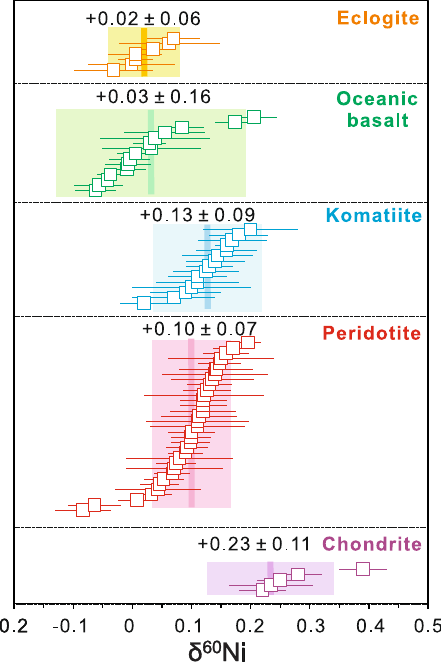
Fig. 2 Mass-dependent Ni isotopic variations of terrestrial silicate rocks and chondrites from this study. The bands represent the average value for each sample category with 2 SD. The δ 60/58 Ni of fi ve chondrite samples fall within the chondritic average de fi ned by all published data (0.23 ± 0.11 ‰ ). The fertile and non-metasomatized peridotites with chemical compositions most close to the BSE 44 have homogeneous Ni isotopic compositions, while those experienced secondary modi fi cation have relatively large variations. Therefore, only fertile, non-metasomatized peridotites are used for the average calculation (0.10± 0.07 ‰ ). Data for chondrites are presented in Supplementary Table 2; Data for peridotites, komatiites, oceanic basalts, and eclogites are presented in Supplementary Tables 4 – 6. Error bars represent 2